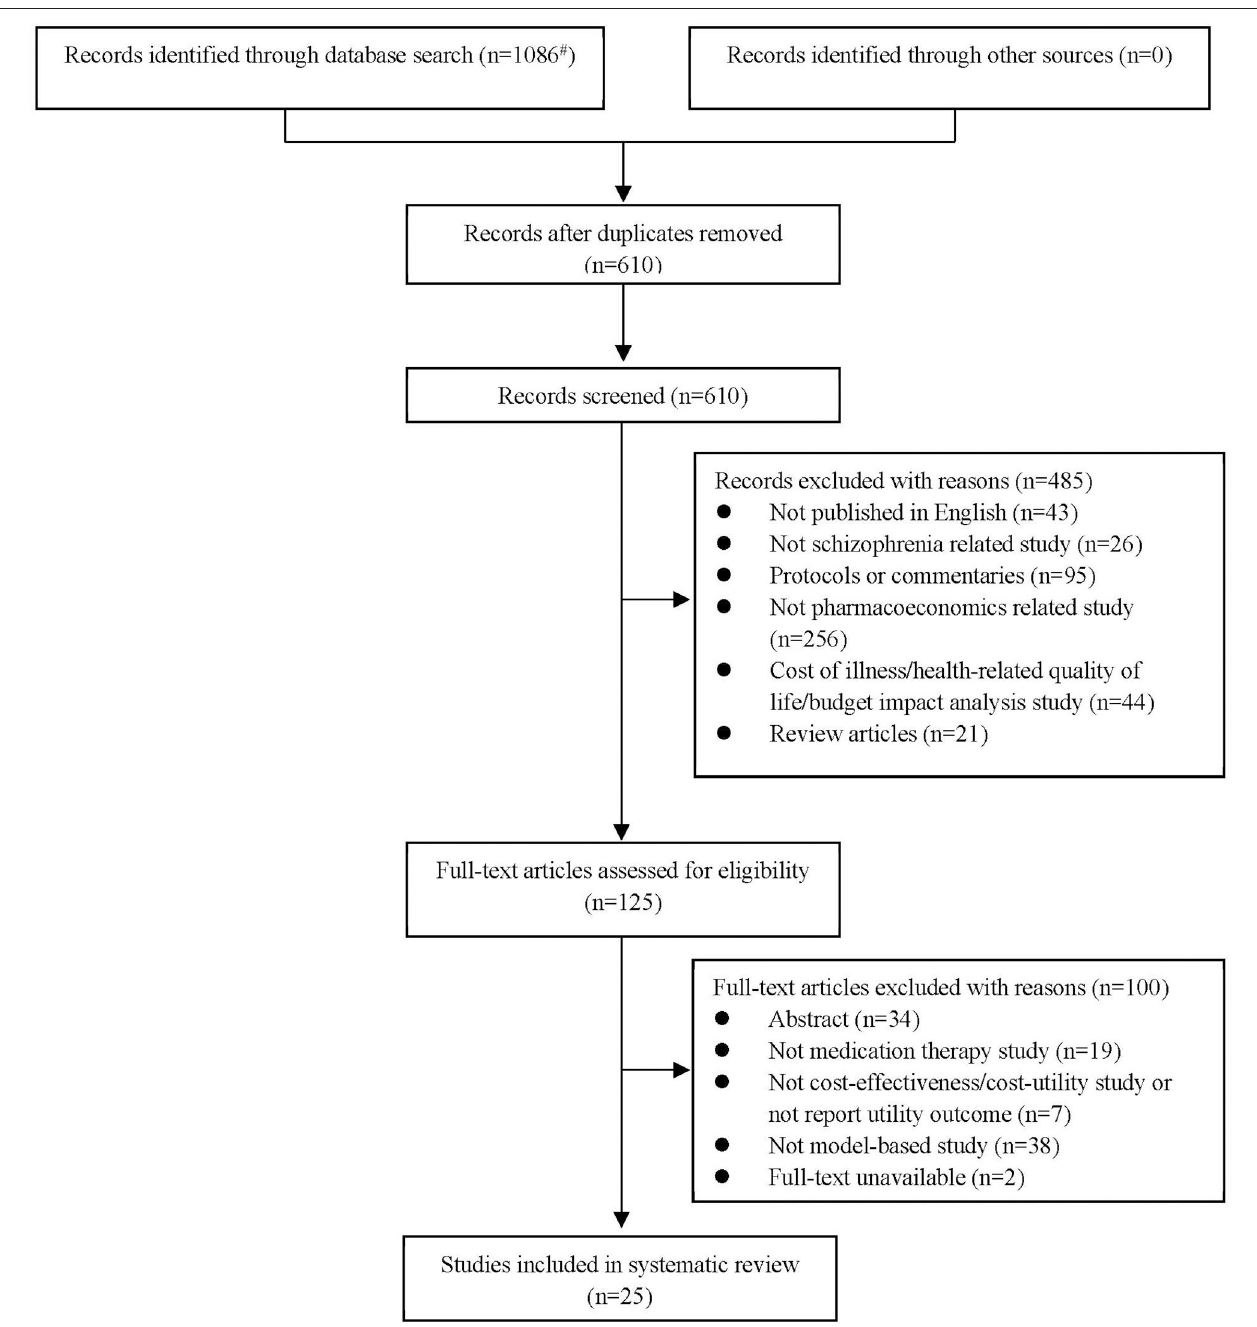
FIGURE 1 | Flow of information through different phases of the systematic review according to the PRISMA statement [ # Detailed search results: PubMed Database ( n 202), Web of Science Database ( n =